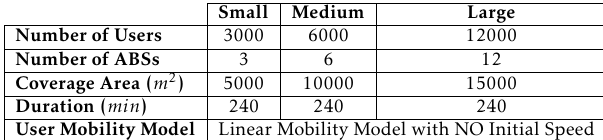
Table 1. Simulation Environment for Different Scale of